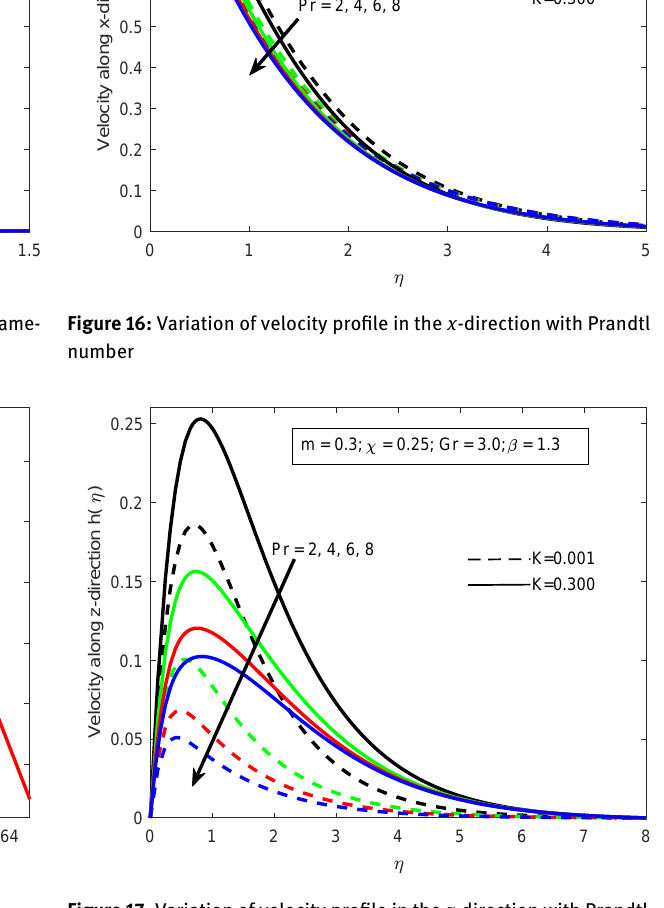
Figure 15: A zoomed portion of Fig. ( ?? ) flow of Casson fluid over a rotating surface with nonuni- form thickness can be canceled by increasing rotational force.